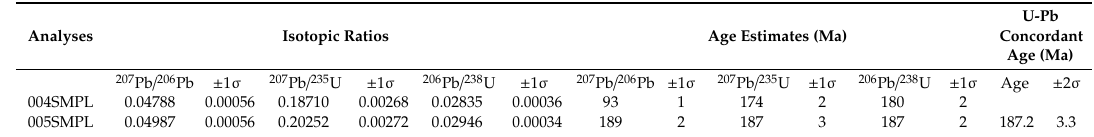
Table 5. U-Pb zircon